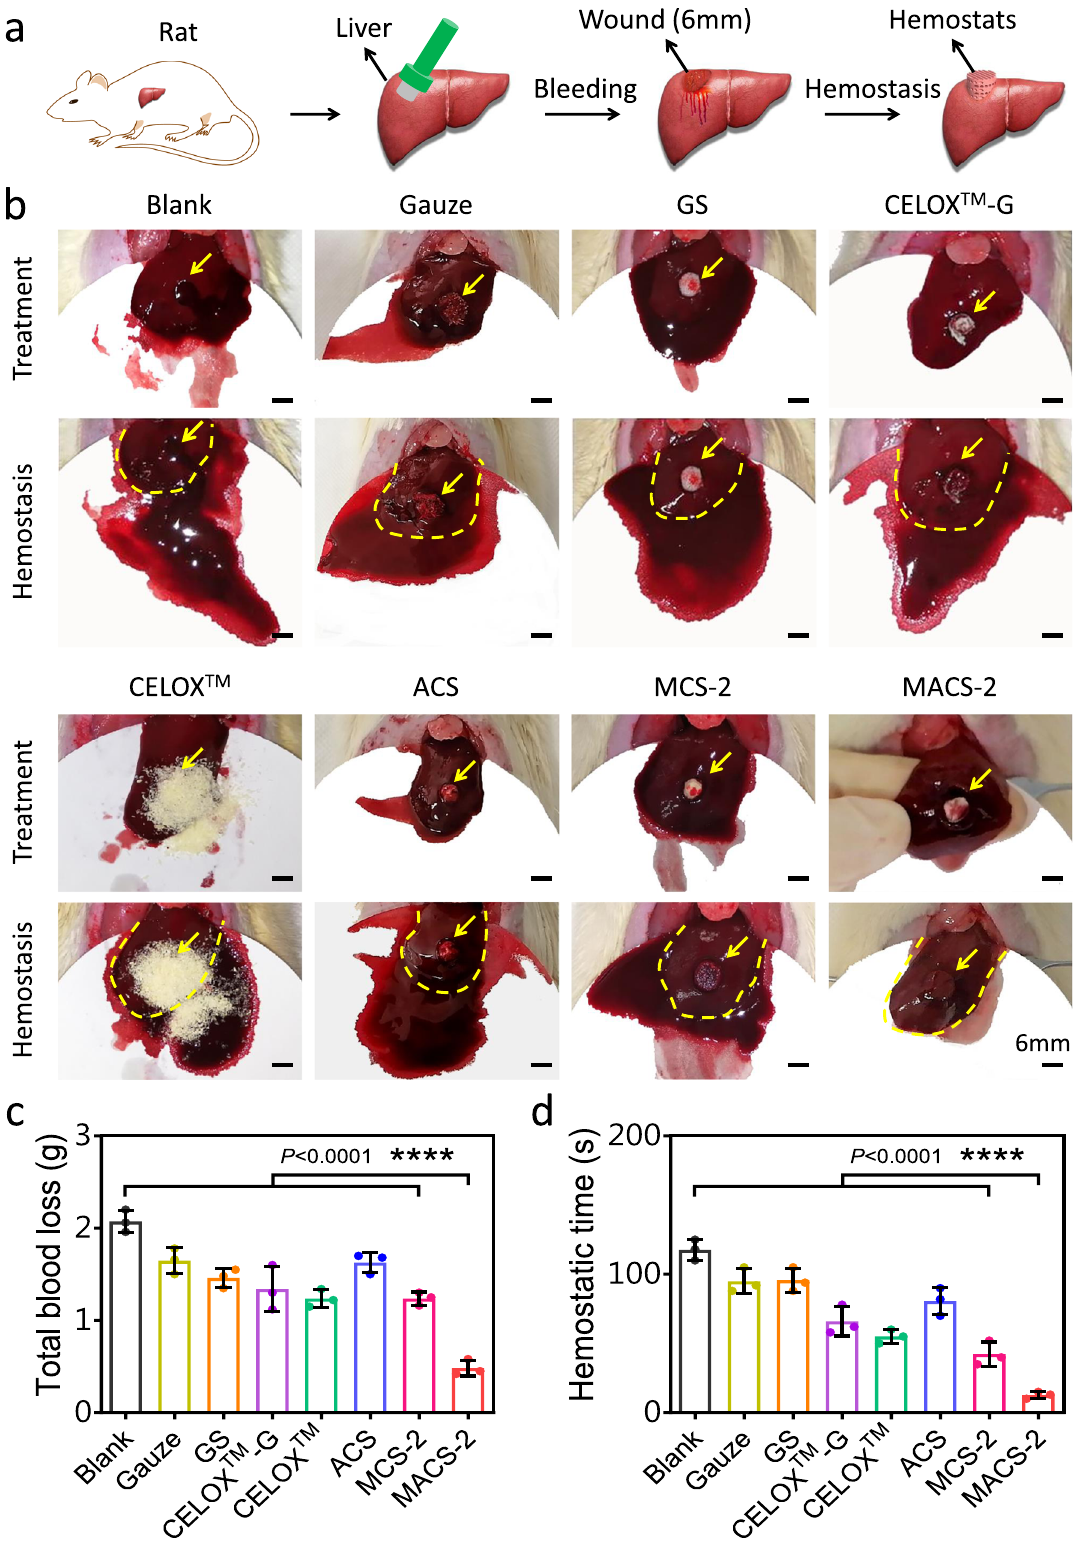
Fig. 6 Hemostasis in the normal rat liver perforation wound model. a Schematic illustration of the hemostatic process of hemostats in a rat liver perforation wound model. b Photographs of the hemostatic effect of the gauze, GS, CELOX TM -G, CELOX TM , ACS, MCS-2, and MACS-2. The yellow arrow and dotted line represented the bleeding site and liver boundary, respectively. c , d Total blood loss and hemostatic time in the gauze, GS, CELOX TM -G, CELOX TM , ACS, MCS-2, and MACS-2 groups. n = 3 rats per group. Data are expressed as mean ± SD. The signi fi cant difference was detected by one-way ANOVA with Tukey ’ s multiple comparisons test. ****P <